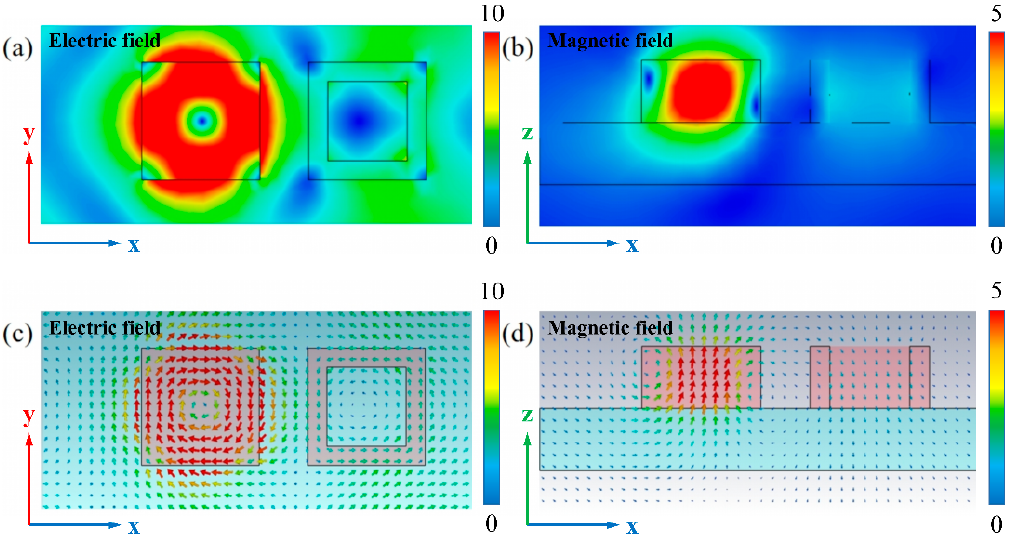
Figure 4. Simulated electric and magnetic field distributions and vector diagrams at the peak position. ( a , c ) Top and cross section views of the electric field distribution (x-y plane at z = 95 nm). ( b , d ) Top and cross section views of the magnetic field distribution (x-z plane at y = 0).